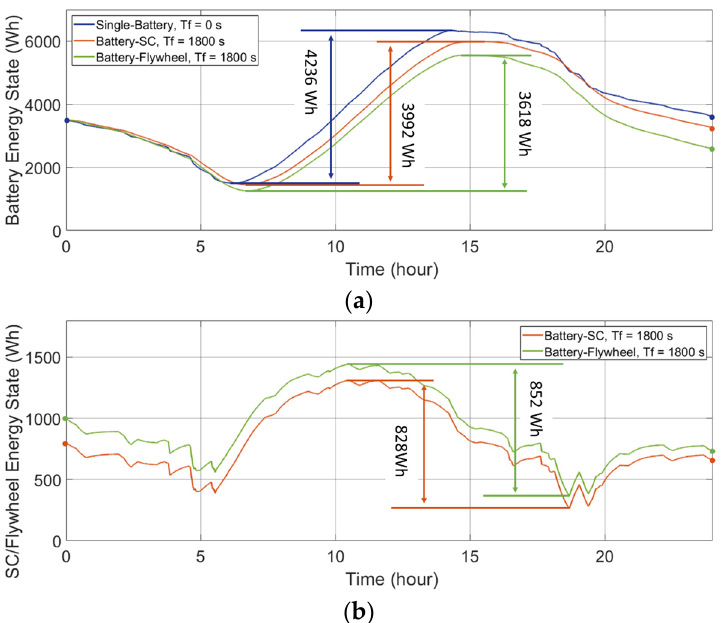
Figure 8. Energy states of the ESDs in the single-battery ESS and the HESSs applied to a PV-powered household-prosumer system. ( a ) Battery energy state. ( b ) SC/flywheel energy state.